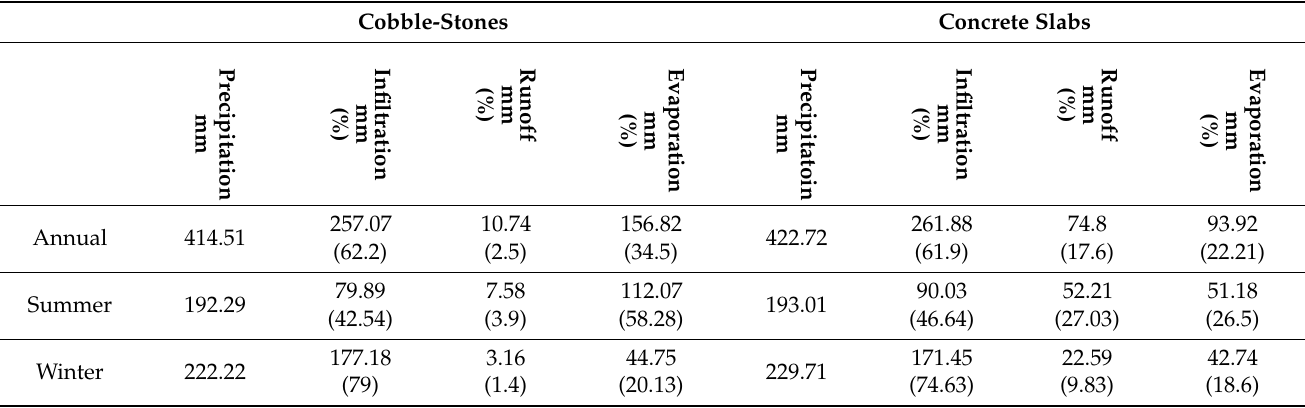
Table 2. Hydrological data balance (June 2016 to June 2017, annual, summer, winter) with absolute (mm) value and share